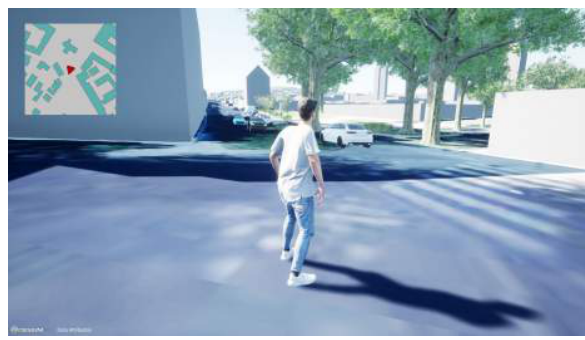
Figure 8. Car Traffic